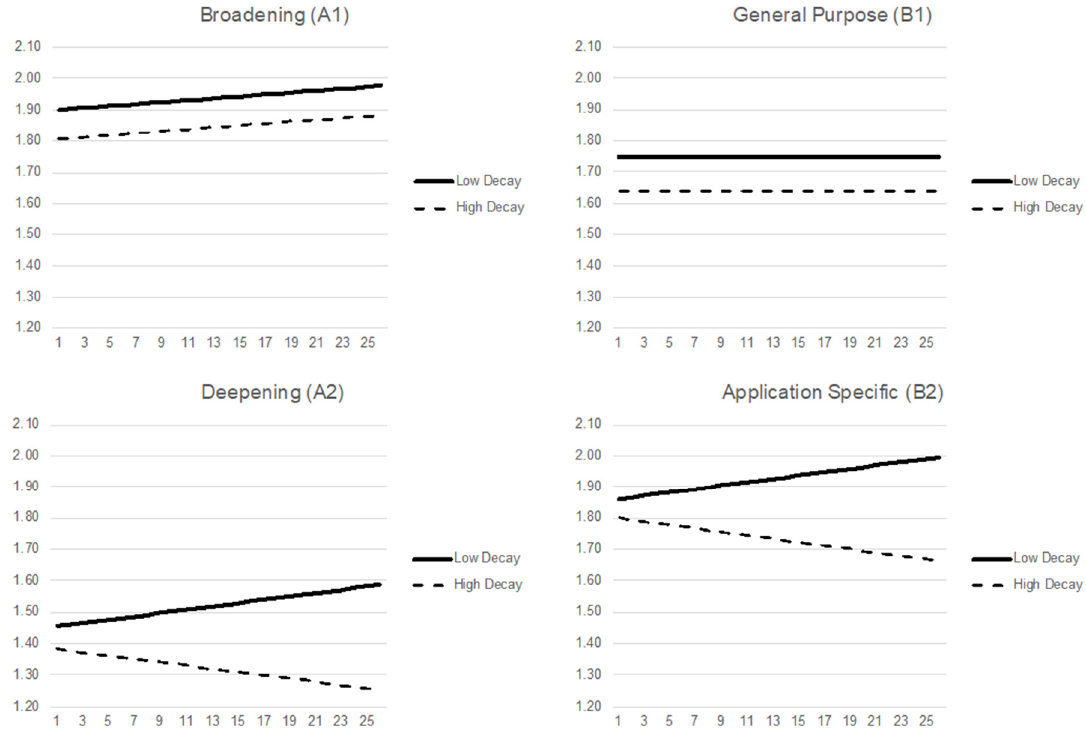
Figure 1. Intangible intensity and decay within contexts of different intangible types (growth): graphs. Regression models and graphs A1 and A2 reveal the effect of the value of BREADTH on the interaction between intangibles intensity and decay. When intangibles are new (low decay), the firm growth benefits from high intensity, regardless of BREADTH or depth degrees—the curve has a positive slope in both A1 and A2—though broadening strategies perform better at equal levels of intangible intensity. The intangible-broadening strategy goes up. Indeed, the negative interaction between decay and intangibles is in place